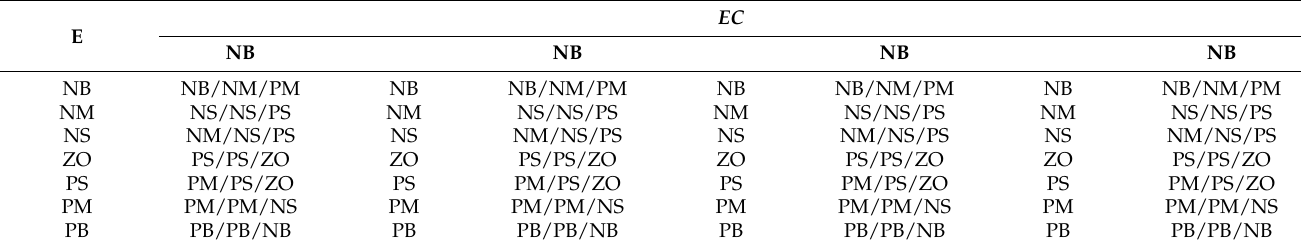
Table 2. Fuzzy PID control